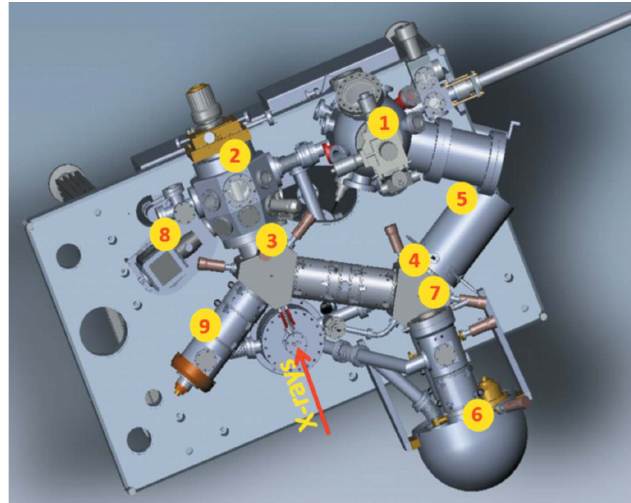
Figure 5 Schematic of the AC-SPELEEM endstation. (1) Preparation chamber, (2) main chamber, (3) first beam separator, (4) second beam separator, (5) AC mirror, (6) energy analyzer, (7) TVIPS-F216 detector (CMOS- camera), (8) UV lamp, and (9) electron gun (LaB 6 ) and the illumination